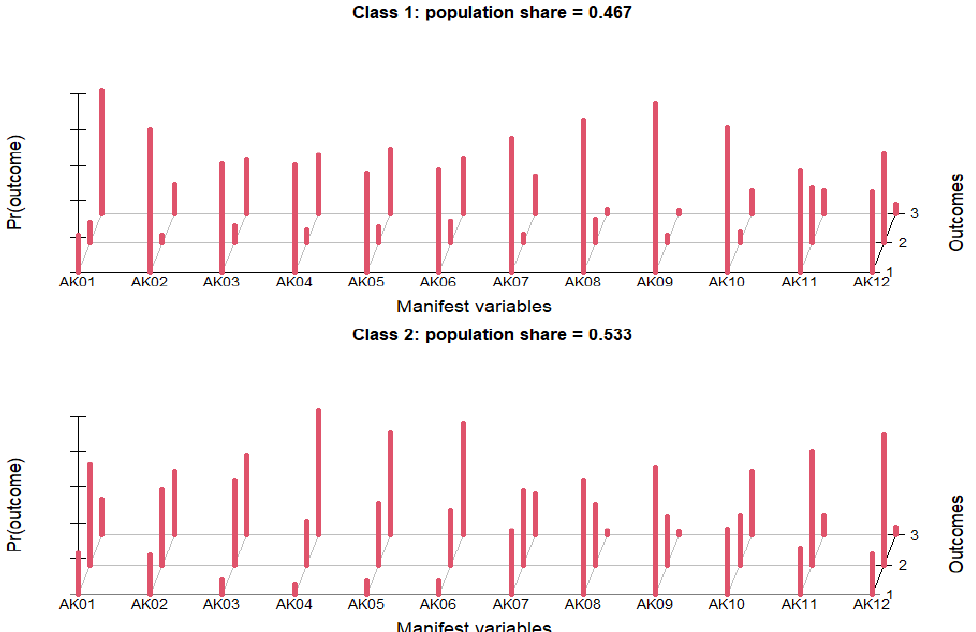
Figure 1. Knowledge regarding antibiotics efficacy, mode of action and antibiotic resistance.